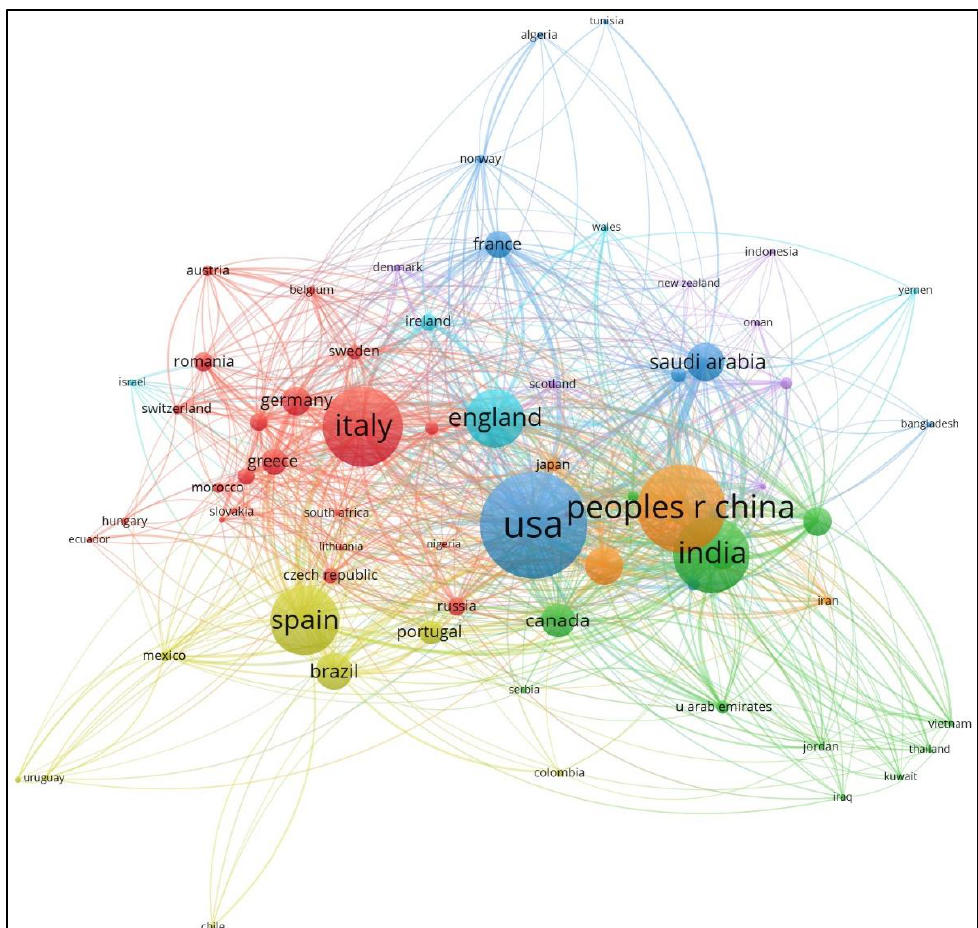
Figure 4. Bibliometric analysis of countries dealing with the topic of Smart cities. Source: own analysis as per Web of Science (2022).